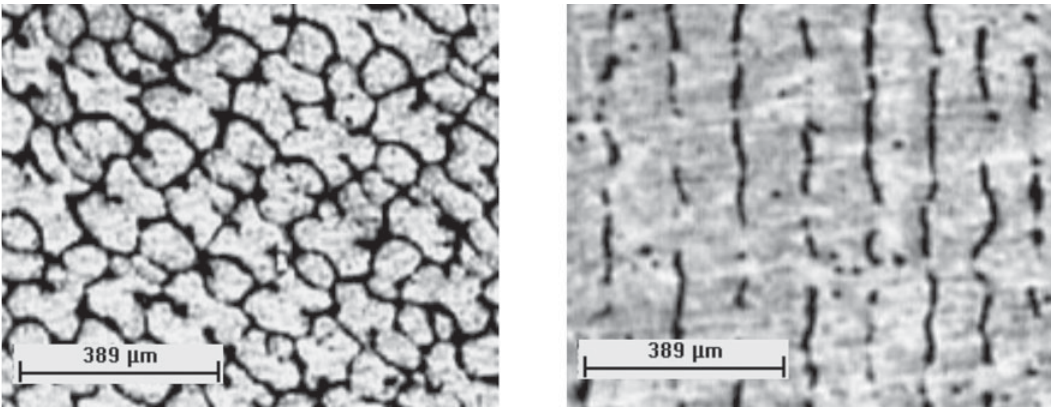
Figure 9. Dendritic microstructure for Sn-5wt%Pb alloy (P = 40 mm, λ